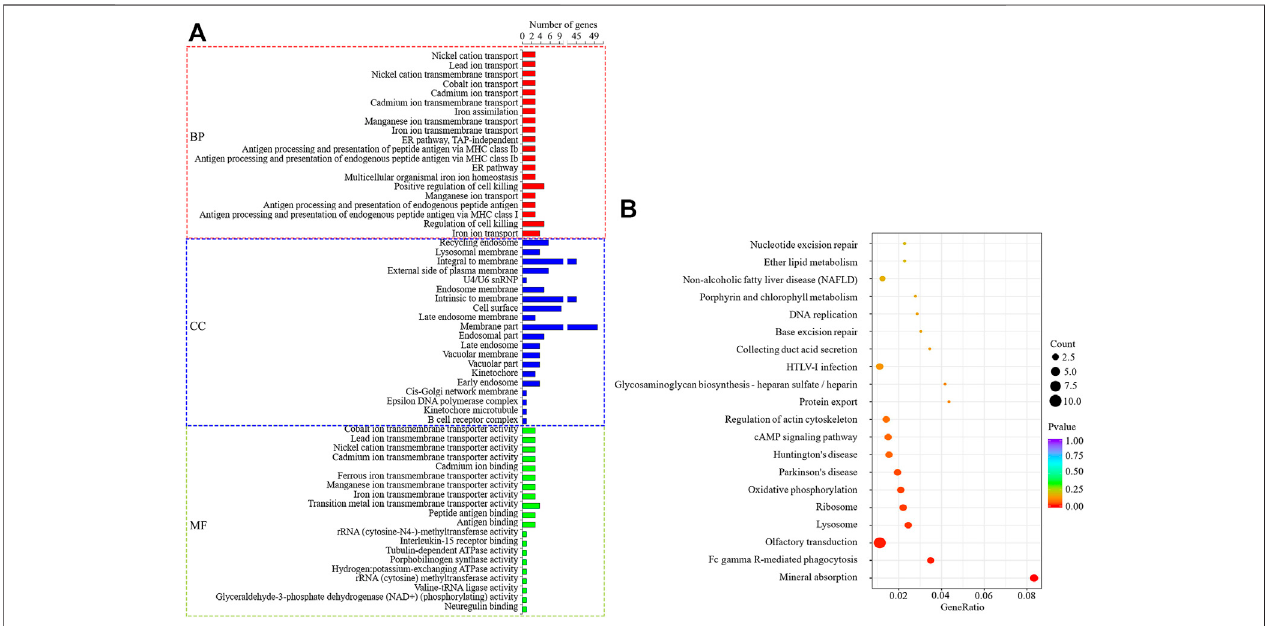
FIGURE 6 | GO and KEGG enrichment analysis of DELs target genes predicted by co-localization. (A) : The fi rst 20 signi fi cant GO items ( p < 0.05). (B) : The fi rst 20 KEGG enrichment results.